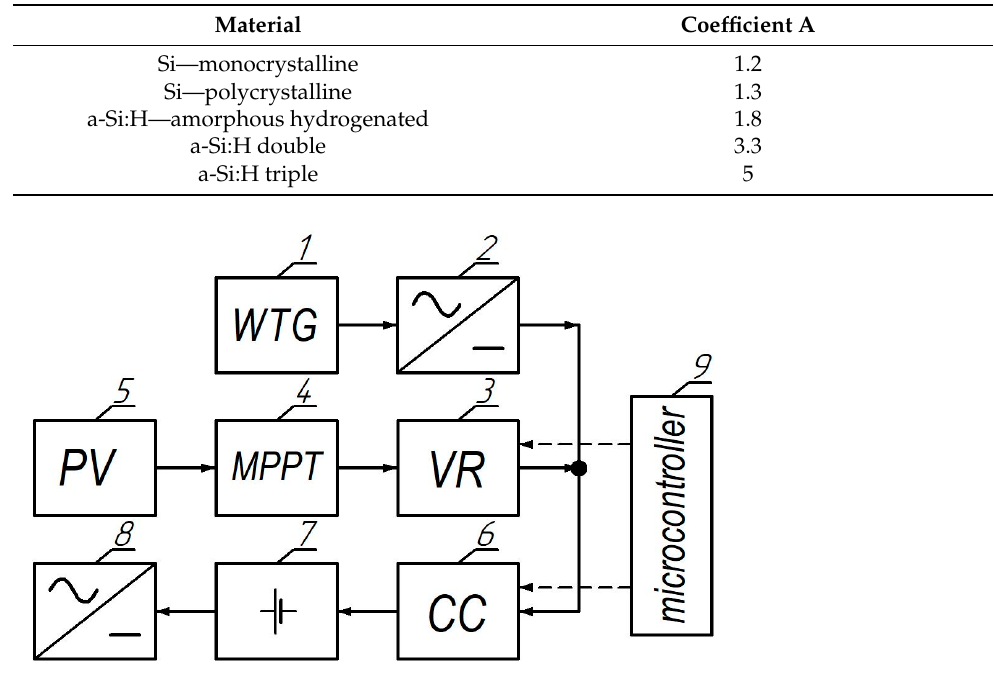
Figure 2. Block diagram of the electrical part of a wind-solar power station.